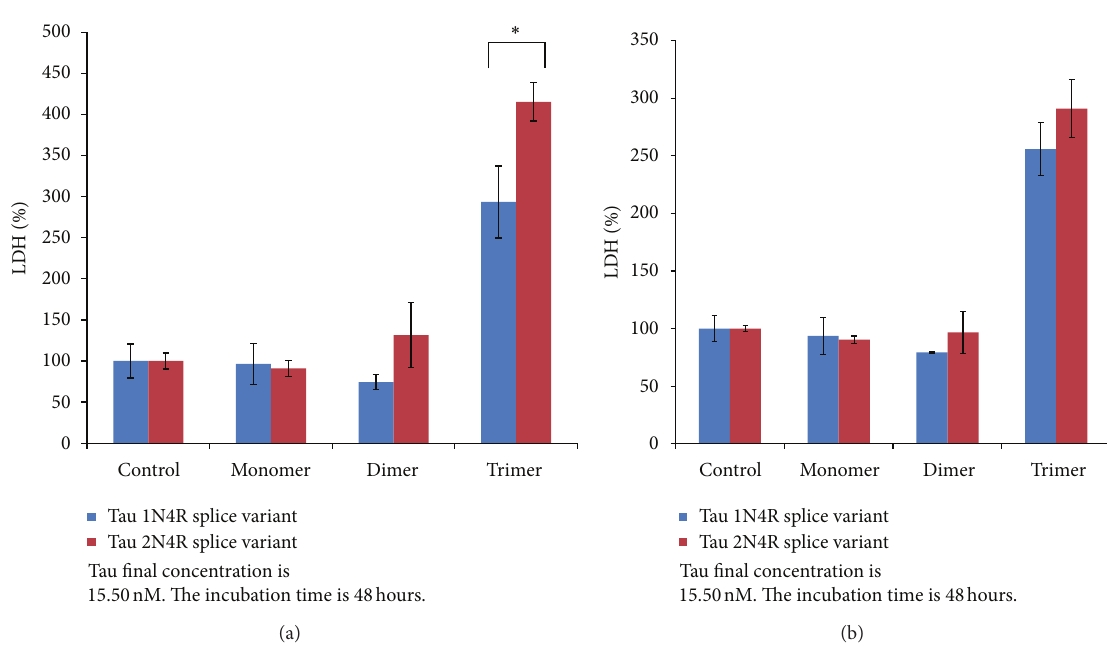
Figure 5: Neurotoxicity of extracellular 15.5nM monomeric, dimeric, and trimeric forms of 1N4R and 2N4R tau variants toward (a) nondifferentiated human neuroblastoma cells (SH-SY5Y) and (b) Retinoic-acid-differentiated SH-SY5Y cells was measured after 48-hour incubation using an LDH assay. For both four-repeat tau isoforms, trimeric form is more neurotoxic than monomeric and dimeric forms ( 𝑃 < 0.001 ) on either neuron type. Full-length trimeric rhTau is more neurotoxic than 1N4R trimeric rhTau. ( 𝑃 < 0.05